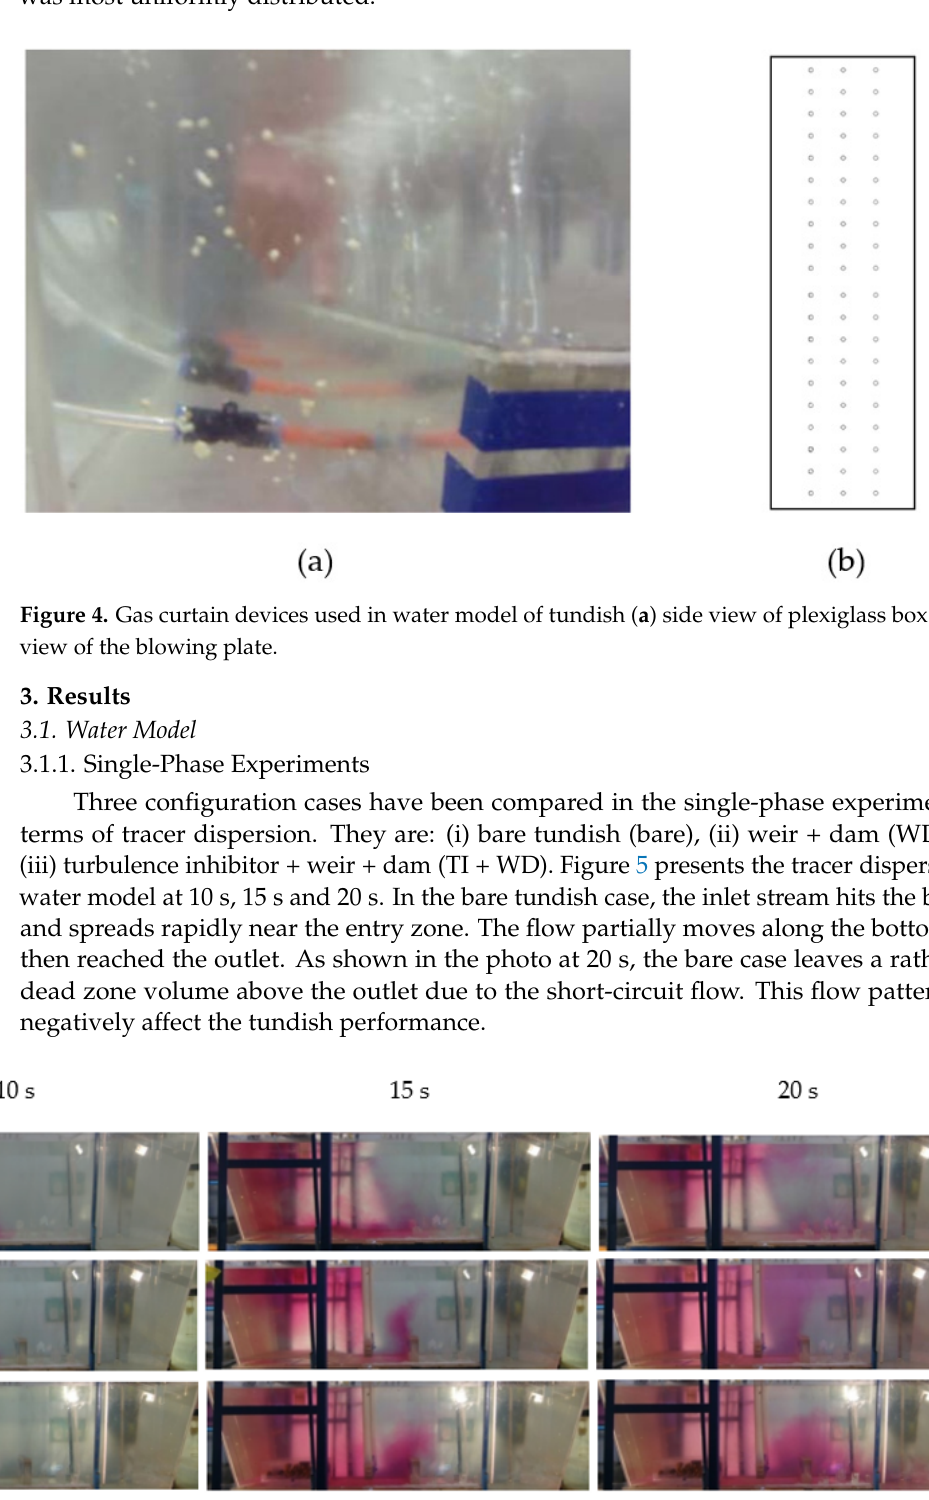
Figure 5. Tracer dispersion in cases of Bare, WD and TI + WD at 10 s, 15 s and 20 s in water experiments.